Question: Write a caption explaining this figure to a reader.
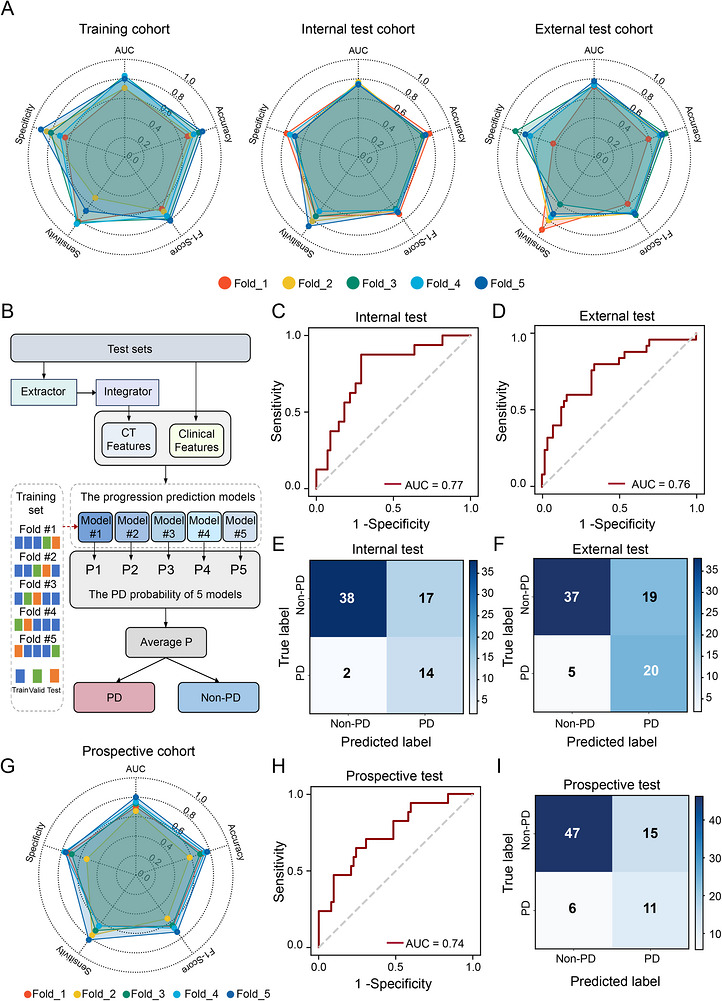
Answer: Performance of the tumor progression prediction model. (A) Performance of the fivefold cross‐validation models in the training, internal test, and external test cohorts. (B) Workflow for predicting progression in the internal and external test cohorts. Temporal multimodal features were input into five distinct models. Each output a predicted probability. The average predicted probability was used to determine the classification as PD or non‐PD. (C and D) ROC curves of the prediction model in the internal and external test cohorts. (E and F) Confusion matrices of model predictions for the internal and external test cohorts. (G–I) Performance of the fivefold models, ROC curve of the ensemble model, and confusion matrix of the ensemble model in a prospective cohort.